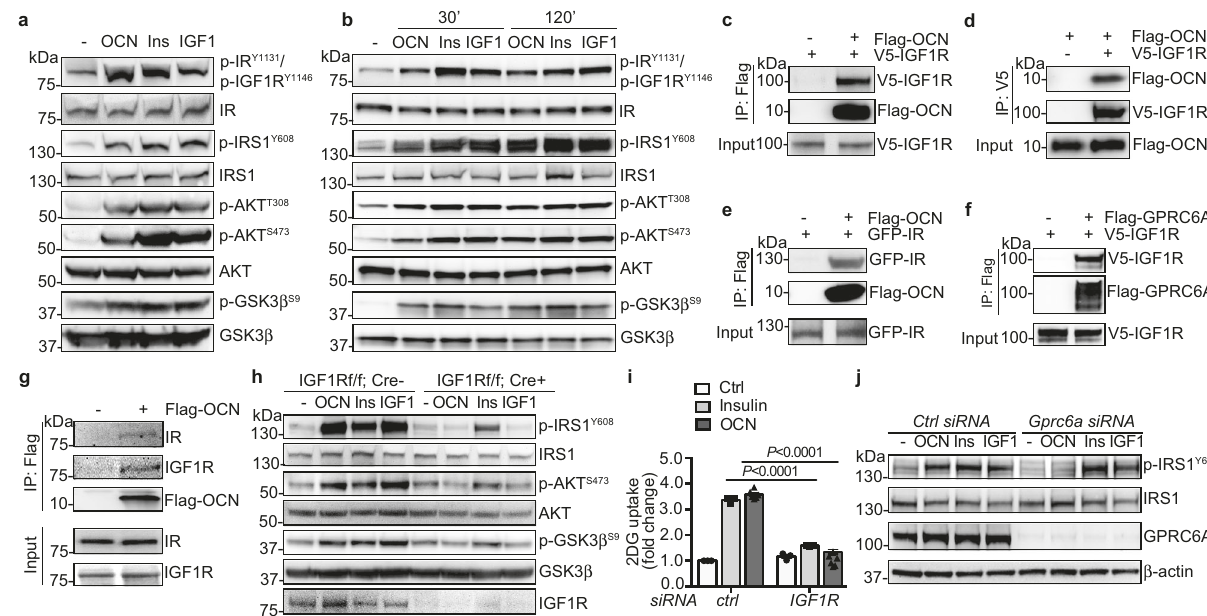
Fig. 5 OCN requires GPRC6A and IGF1R for the activation of the downstream insulin signaling pathway. a , b OCN promoted insulin signaling in skeletal muscle ( a ) and liver ( b ). Ins, insulin. c – f OCN was associated with IGF1R ( c , d ) and IR ( e ), and GPRC6A was associated with IGF1R ( f ) in HEK 293 cells. g OCN was in the complex with endogenous IR and IGF1R in primary hepatocytes. h IGF1R was required for OCN-induced phosphorylation of insulin signaling mediators in primary hepatocytes. i IGF1R knockdown inhibited OCN-promoted 2DG uptake. C2C12 cells were transfected with IGF1R siRNAs and then treated with OCN or insulin for 2 h. n = 3 for three independent repeats of each experiment. j GPRC6A knockdown inhibited OCN-induced phosphorylation of insulin signaling mediators in primary hepatocytes. n = 3 ( i , ctrl, Insulin), 6 ( i , OCN). Data are presented as mean ± SEM. Analysis was two-way ANOVA followed by Fisher ’ s LSD multiple comparison test ( i ).